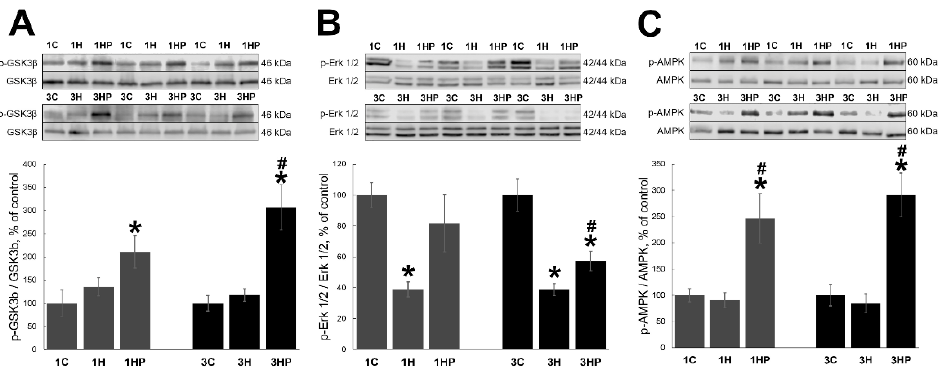
Figure 5. Evaluation of the p-GSK3b ( A ), p-ERK1/2 ( B ) and p-AMPK ( C ) content in soleus muscles of non-treated control rats (1C and 3C), rats after 1 and 3 days of unloading (1HS and 3HS), and 1 and 3 days of HS with PRB inhibitor (1HP and 3HP). Values are normalized to the level of total GSK3b ( A ), total ERK1/2 ( B ) and total AMPK ( C ) in each sample. n = 8. * indicates a significant difference from the control, # indicates a significant difference from the HS group, p < 0.05.